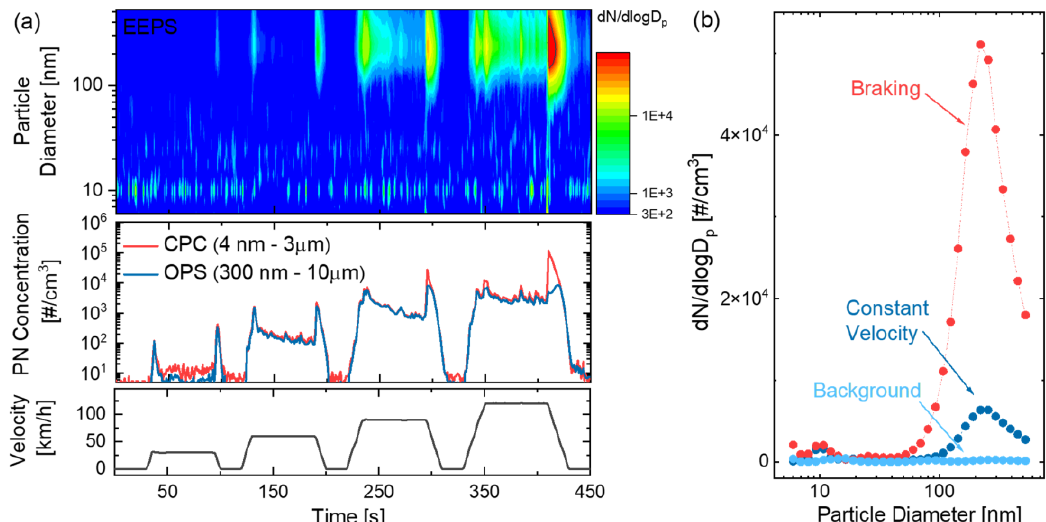
Figure 3. ( a ) Test cycle to characterize brake particle emissions for acceleration, constant speed, and braking. Displayed is the particle size distribution measured by the EEPS as well as the particle number concentration from the CPC and OPS during the test cycle. ( b ) Size distribution from the EEPS for different driving situations: constant speed of 120 km/h, deceleration, and stationary.